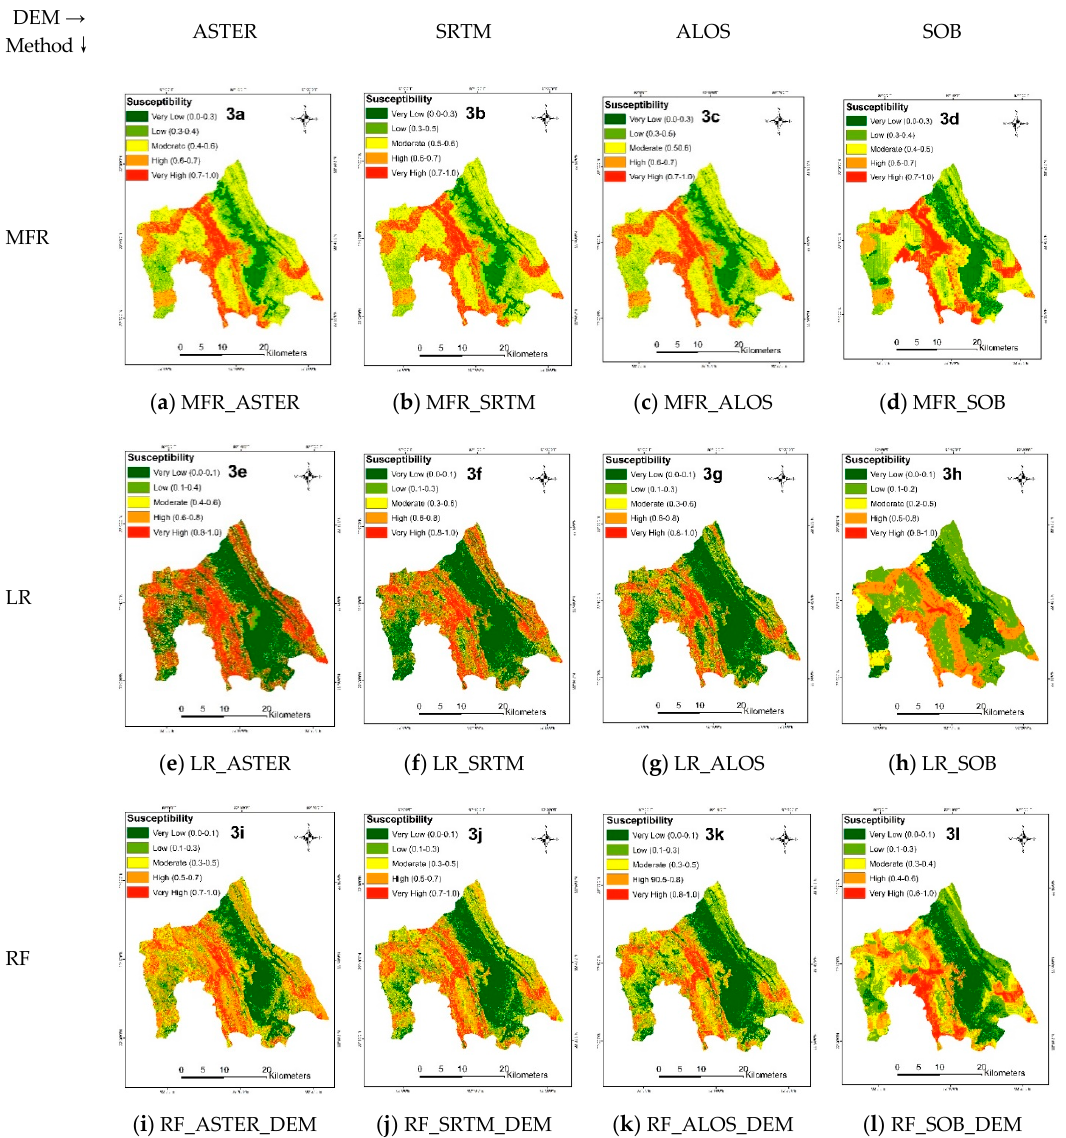
Figure 3. Landslide susceptibility maps produced using MFR, LR, and RF models (all 15 factors).